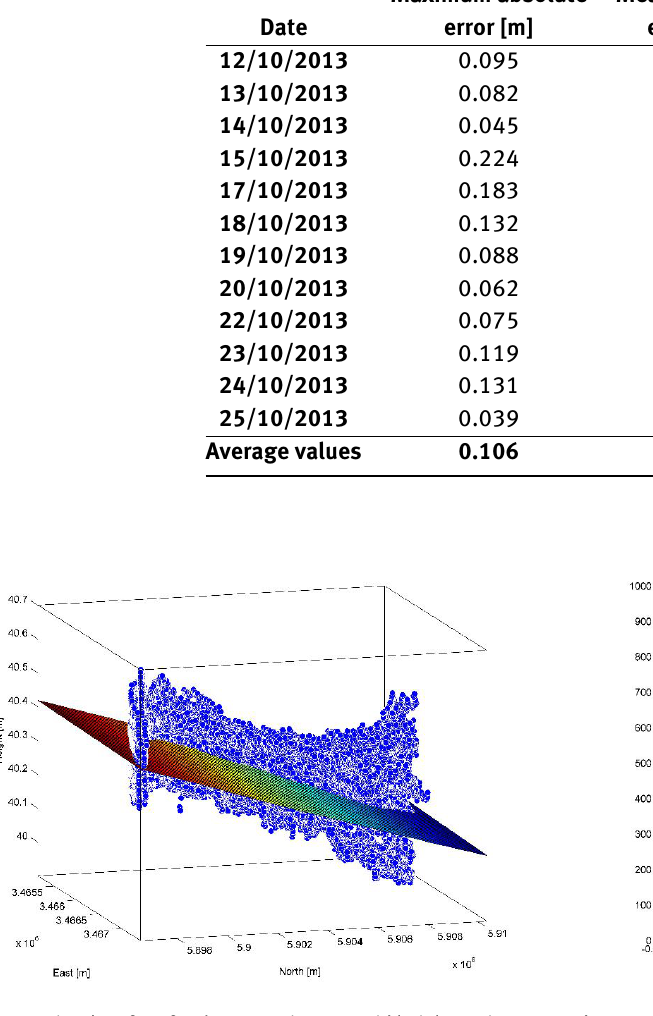
Figure 10: Fitted surface for the approximate geoid heights using local linear regression.